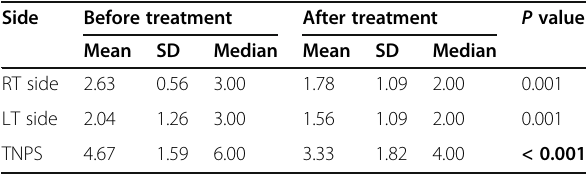
Table 4 Total nasal polyps score (TNPS) before and